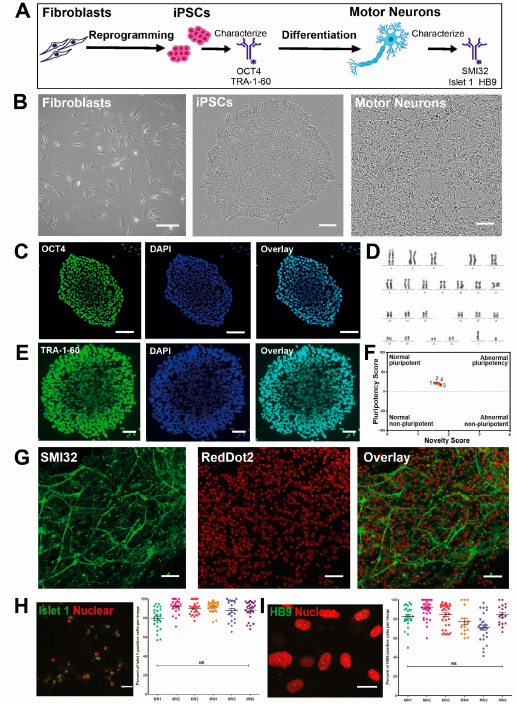
Figure 1. Generation of patient induced pluripotent stem cell (iPSC)-derived motor neurons from fibroblasts. ( A ) Schematic timeline of iPSC reprogramming and motor neuron di ff erentiation. Cells were characterised by immunocytochemistry and ubiquitomics at the pluripotent stem cell stage and motor neuron stage. ( B ) Representative brightfield images of fibroblasts at day 0 of reprogramming, iPSCs on day 2 after passaging, and motor neurons on day 76 of di ff erentiation. Scale bar represents 100 µ m. ( C ) Representative epifluorescent images of OCT4 expression (immunofluorescence) in an iPSC colony grown on Matrigel-coated tissue culture plates in TeSR E8, 2 days following passage, with DAPI staining (nucleus). Scale bar represents 100 µ m. ( D ) Representative iPSC karyogram confirms the absence of introduced chromosomal abnormalities. ( E ) Representative epifluorescent images of TRA-1-60 expression (immunofluorescence) in an iPSC colony grown on Matrigel-coated tissue culture plates in TeSR E8, 2 days following passage. Scale bar represents 50 µ m. ( F ) PluriTest results following comparison of the reprogrammed stem cells to previous characterised cells. ( G ) Representative scanning confocal micrographs of iPSC-derived motor neurons stained showing expression of neuronal marker neurofilament heavy (SMI32) by immunofluorescence, with RedDot2 staining (nucleus). Motor neurons were cultured for 76 days on laminin, collagen I and fibronectin-coated plates. Scale bar represents 100 µ m. ( H ) Representative scanning confocal micrographs of iPSC-derived motor neurons stained showing expression of neuronal marker Islet 1 by immunofluorescence, with RedDot2 staining (nucleus), and image quantification via Image J analysis in six cell lines. NS = no significant di ff erence by one-way ANOVA. Scale bar represents 50 µ m. ( I ) Representative scanning confocal micrographs of iPSC-derived motor neurons stained showing expression of neuronal marker HB9 by immunofluorescence, with RedDot2 staining (nucleus), and image quantification via Image J analysis in six cell lines. Scale bar represents 25 µ